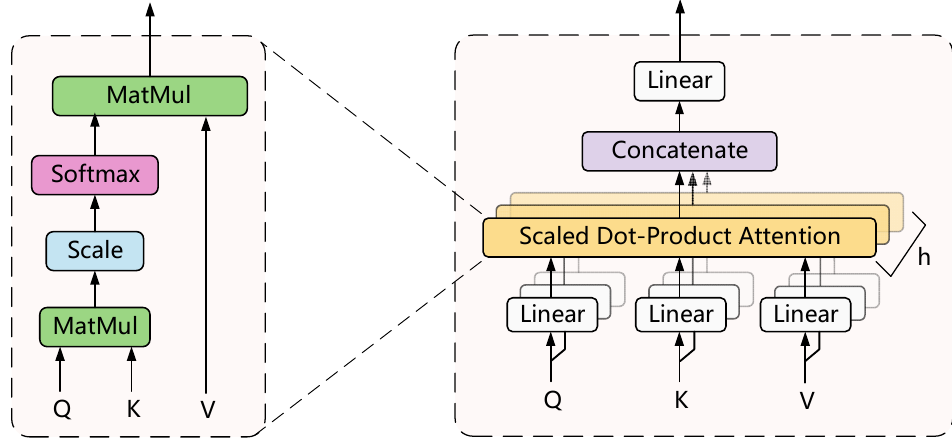
Figure 6. Architecture of the multihead self ‐ attention layer.